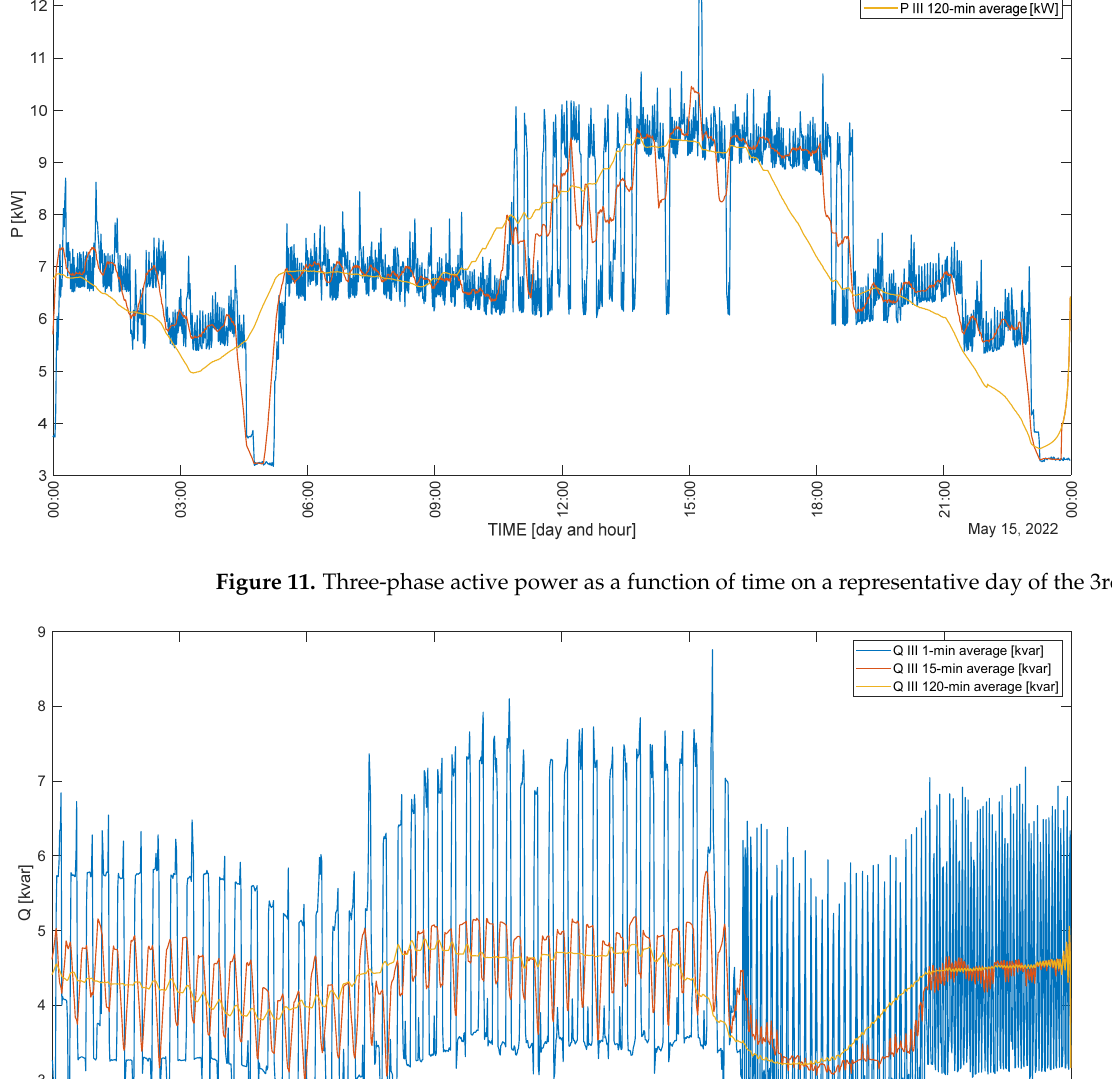
Figure 10. Three-phase active power as a function of time on a representative day of the 2nd stage.